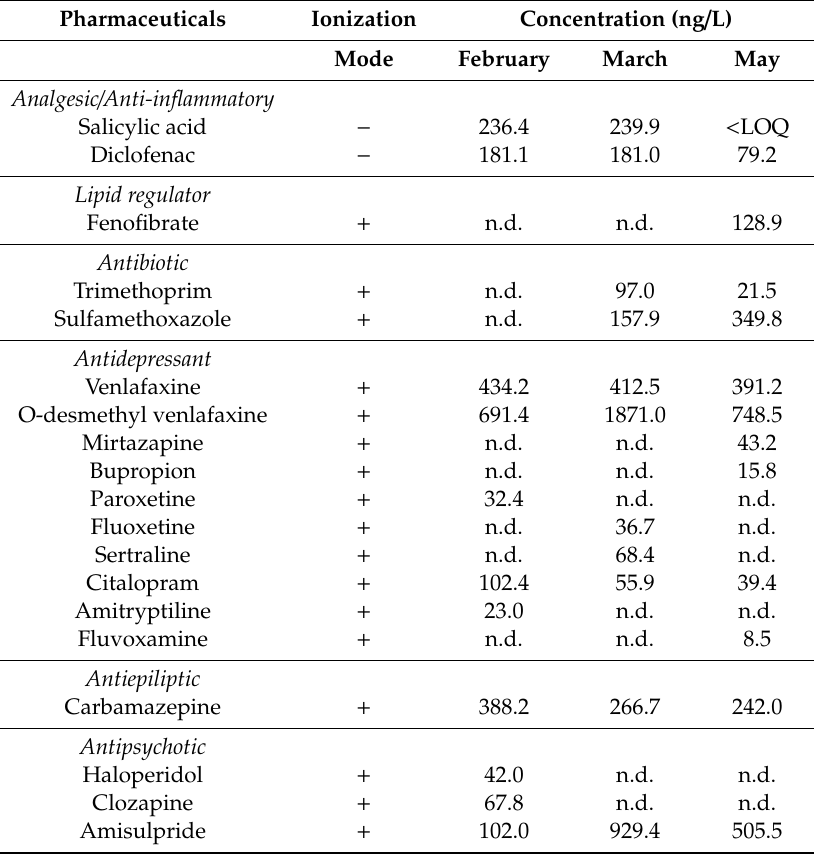
Table 2. Concentration levels (ng / L) of pharmaceutically active compounds (PhACs) identified in real hospital wastewater treatment plants (WWTP) e ffl uent in the three sampling campaigns by UHPLC–LTQ / Orbitrap MS.